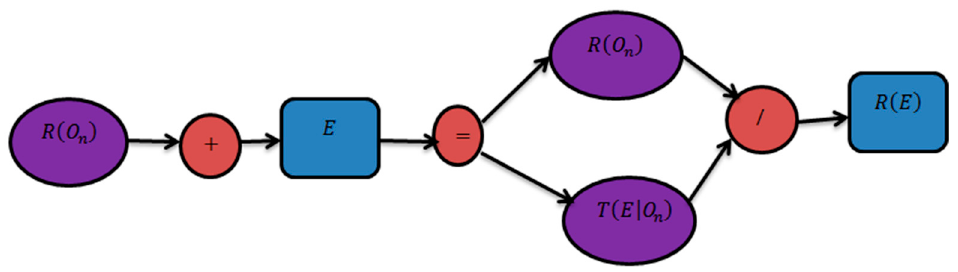
Figure 8. Low computational